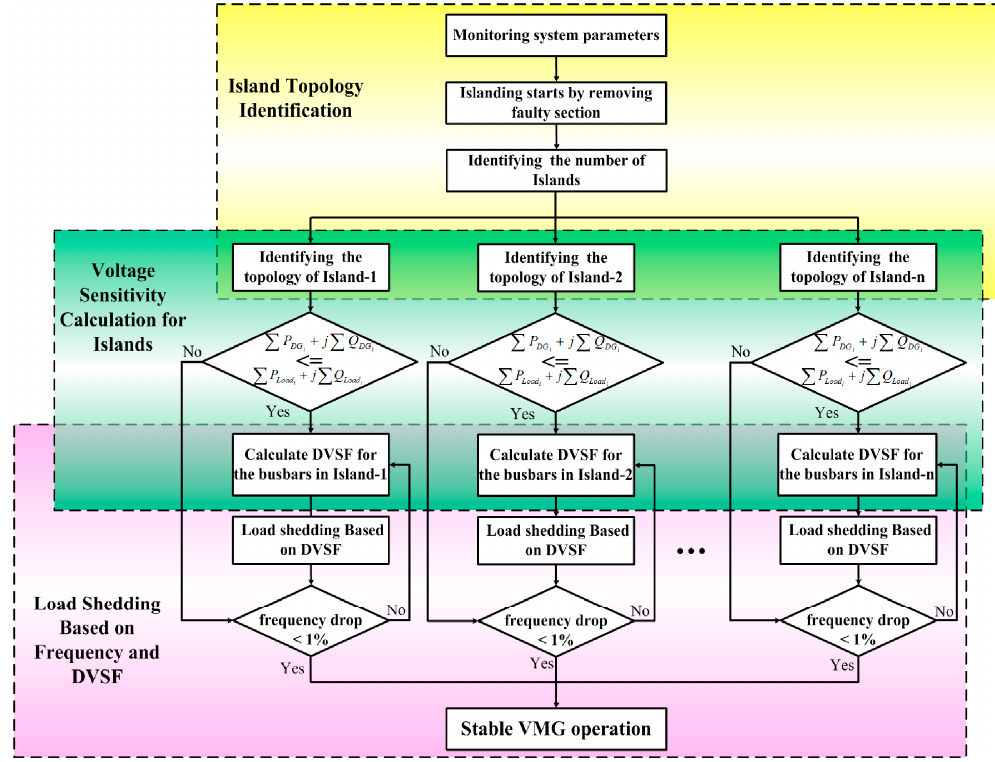
Figure 3. Flowchart of the proposed scheme to stabilize a system after